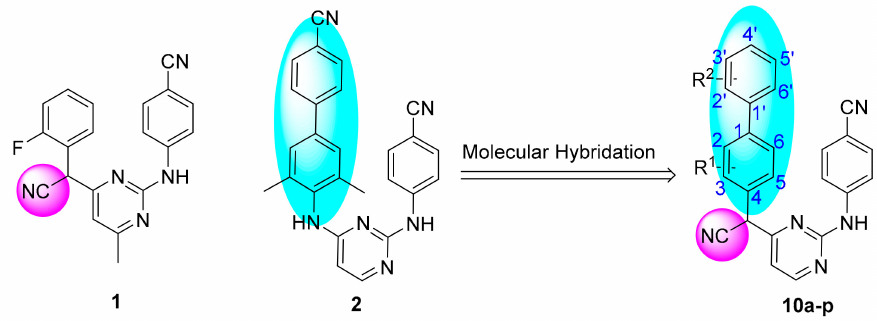
Figure 2. The optimization strategy of CN-biphenyl-diarylpyrimidines